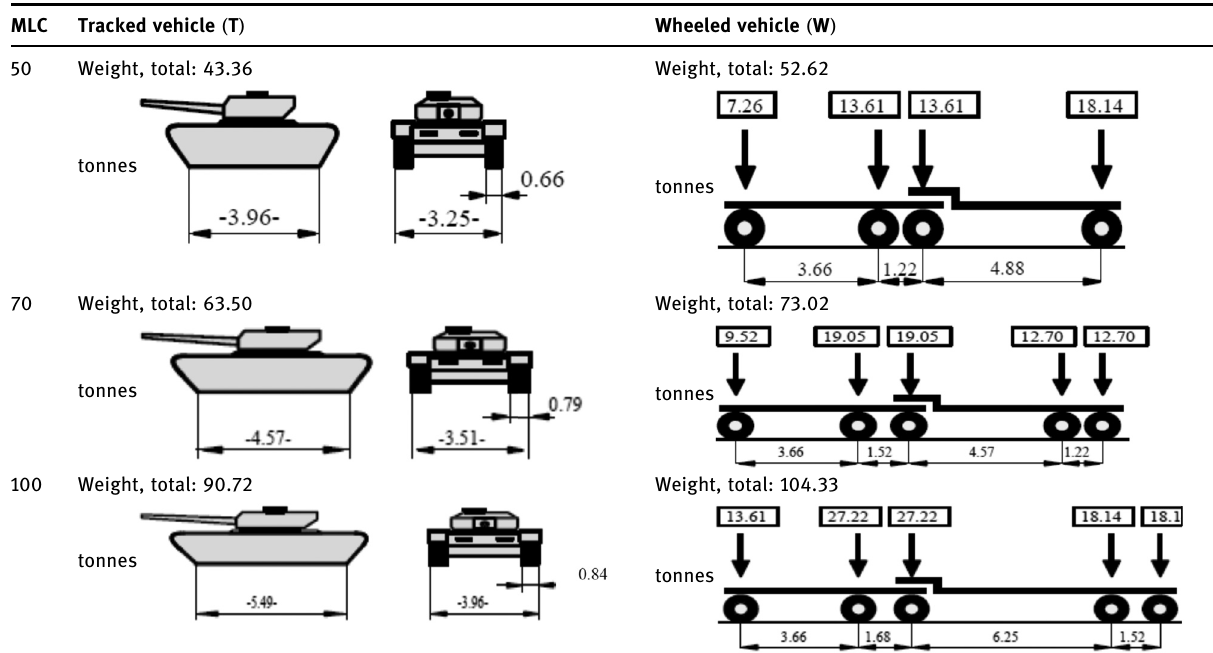
Table 1: Comparison of selected MLC classes based on the STANAG 2021 standard [ 3 ]